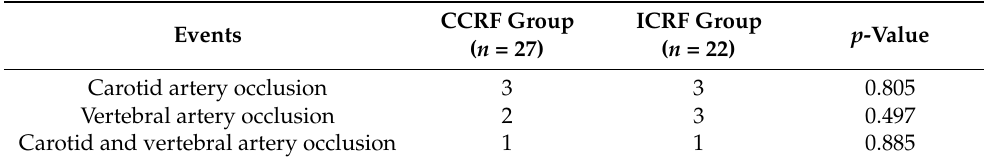
Table 2. Concurrent carotid or (and) VA severe stenosis or (and) occlusion in 49 patients of two subtypes of